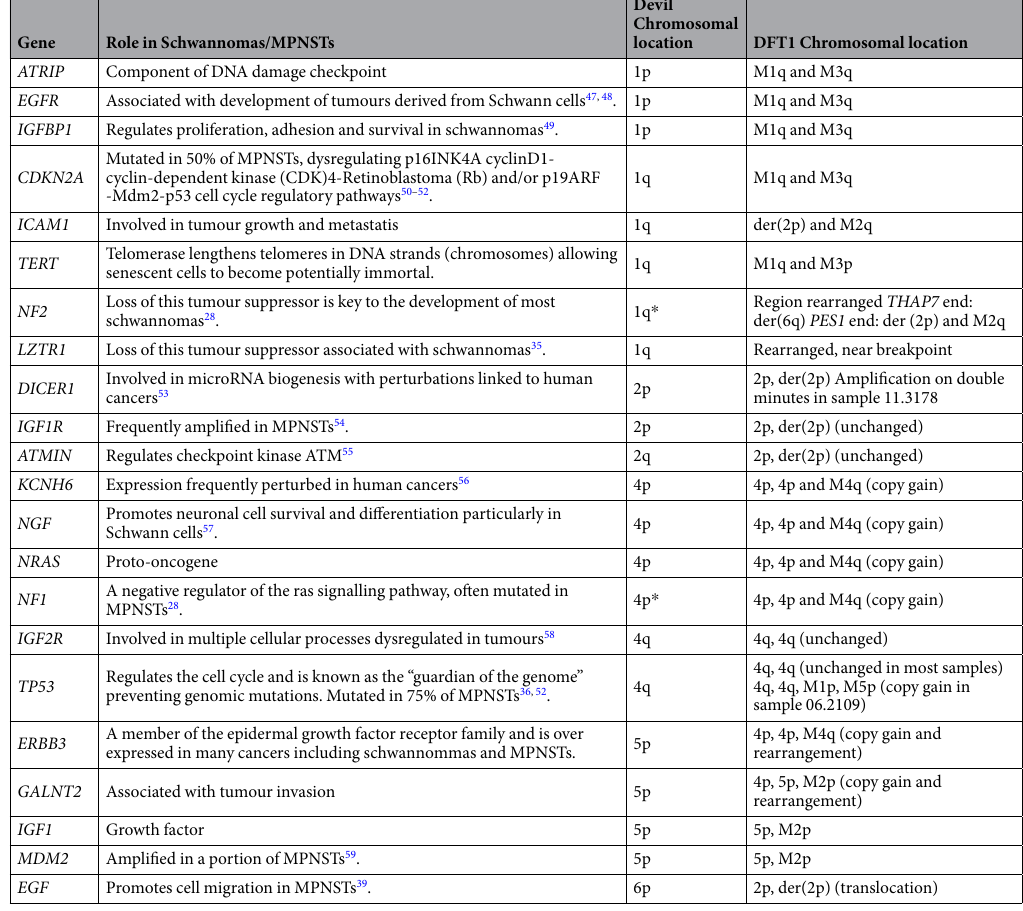
DFT1 pathogenesis. Of the 22 genes selected for mapping, those of particular interest for further investigation are those in a very different genomic context (e.g. located on a different chromosome) compared to the normal arrangement and/or show a change in copy number in the tumour common to all strains (Table 1). The event leading to DFT1 tumourigenesis is proposed to be the fusion of chromosome 1 with an X chromo- some, which led to a series of breakage-fusion-bridge cycles and extensive rearrangement of chromosome 1 mate- rial on M1 13, 18 . With this idea in mind, along with the now seemingly stable nature of the extensively rearranged chromosome 1 material in DFT1, chromosome 1 is a likely source for DFT1 driver mutations. Although many genes have been implicated with cancer, we chose candidates based on their known association with nerve cell neoplasms or being commonly involved in cancers more generally. The strongest candidate on devil chromosome 1 is NF2 . This hypothesis is based on the frequency of breakpoints in the region encompassing NF2 in humans (corresponding to 22q11-13) involved in MPNSTs 26, 27 , and the role of the loss or inactivation of NF2 in Schwann cell tumours 28 . Although we were unable to isolate and map the NF2 gene as part of this study, we demonstrated that this region of the DFT1 genome has undergone rearrangement and even some deletion, including the dele- tion of one copy of the tumour suppressor LZTR1 29 (Fig. 4b). The additional mapping of chromosome 1 genes on devil and DFT1 chromosomes enabled a scenario for the initial chromosome rearrangements contributing to DFT1 tumourigenesis to be proposed (Fig. 7). Previous research has suggested the loss of telomeres led to the fusion of chromosomes 1 and X 13, 18 . Our mapping data suggest the initial fusion most likely occurred close to the NF2 region at the distal end of 1q and the distal end of Xq. Therefore, the NF2 region would have been close to the original site of genome instability and a site of further instability, with this region being separated from the rest of chromosome (translocated to chromosome 2 and 6). The other copy of this region, located on chromosome M2 has also experienced rearrangement and even deletion ( OSBP2 , THAP7/LZTR1 ). NF2 is a tumour suppressor involved in regulating intracellular signalling pathways and cell cycle progres- EFGR are overabundant on the cell surface, upregulating their downstream targets, thereby driving cell pro- liferation 31–33 . This is particularly interesting in light of the mapping of ERBB3 in DFT1. ERBB3 is in a very different genomic context in the tumour (located on chromosome 4 rather than 5) and has experienced a copy number gain (Fig. 5). Consistent with the Schwann cell origin of DFT1 3 , it is therefore not surprising to find